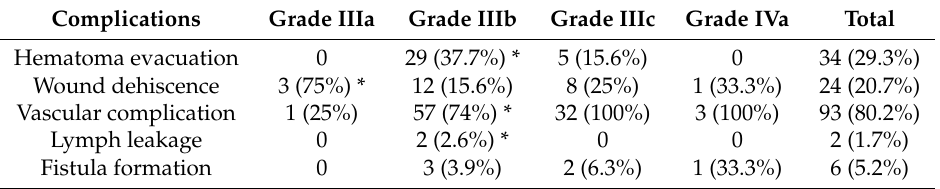
Table 1. Complications requiring unplanned second